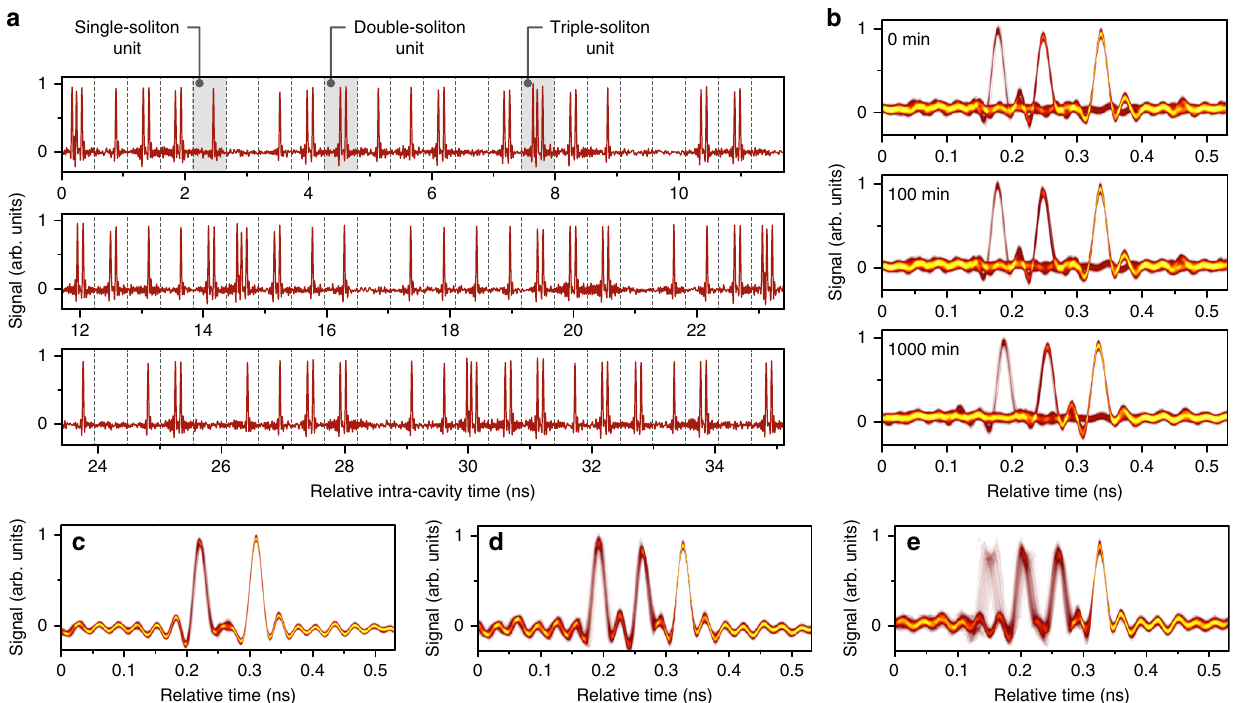
Fig. 2 Typical soliton supramolecules and their long-term stability. a Time-domain trace of a typical soliton supramolecule (only 66 out of 154 time-slots are shown). b Persistence-mode recordings of this soliton supramolecule at 0, 100, and 1000 min. c – e Persistence-mode recordings of three typical soliton supramolecules containing two solitons in every unit ( c ), three solitons in every unit ( d ), and both triple- and quadruple-soliton units ( e